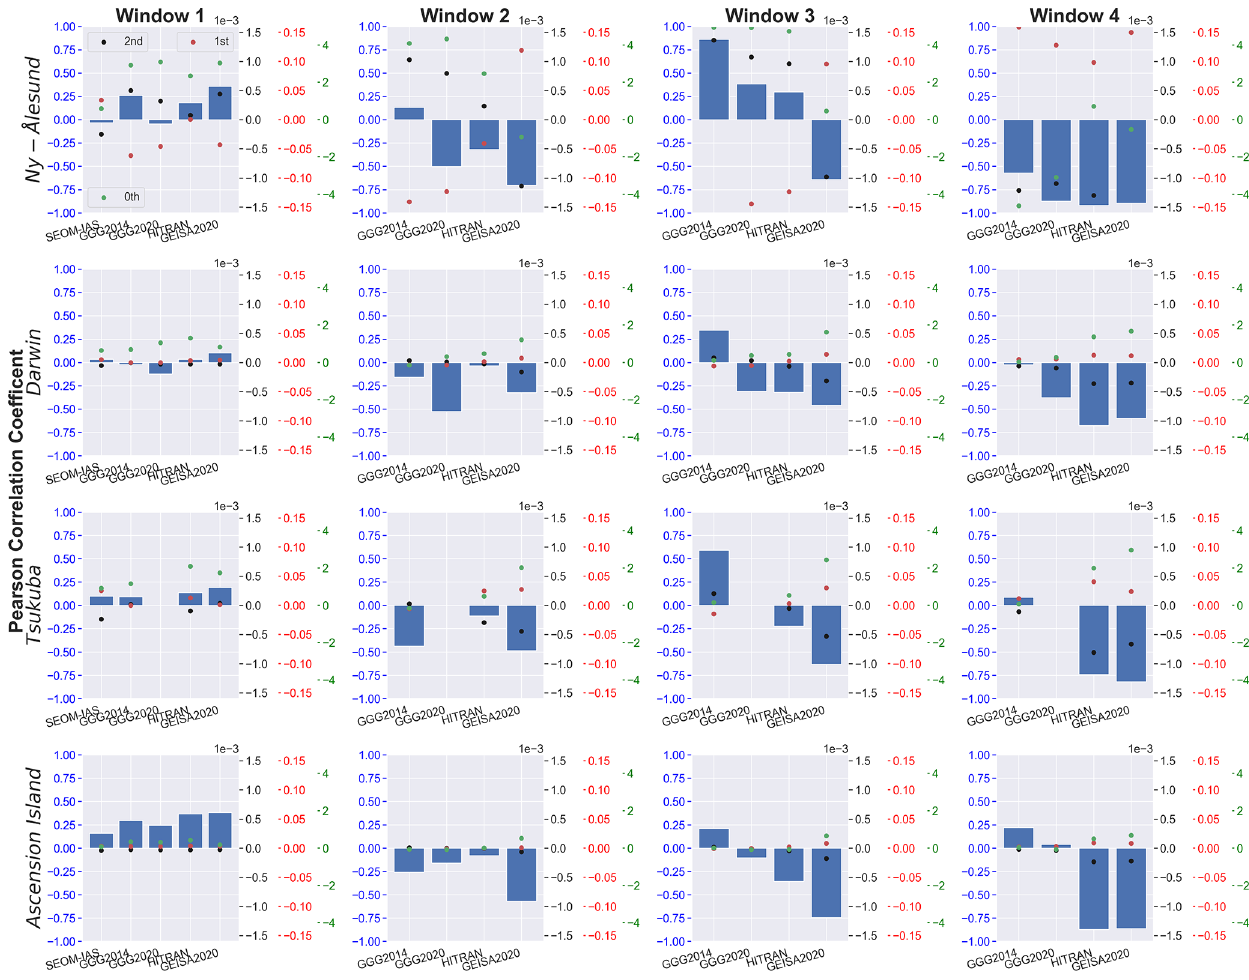
Figure 10. Bar and scatter charts indicating the statistics behind the sensitivities to SZA variations shown in Fig. 9. Each row indicates the results from a TCCON site, as indicated by the y -axis label; each column shows the results from a particular window as shown by the column title. The blue bar plots show Pearson’s correlation coefficients, with the left-hand blue y -axis values giving the appropriate scale. The black dots show the second-order coefficients from the regression from the fits shown in Fig. 9, with the right-hand black y -axis values as the scale. The red dots show the first-order coefficients, corresponding to the right-hand red y axis, and the green dots show the constant values corresponding to the right-hand green y axis. Note all values for GGG2020 at the Tsukuba site have been removed due to p -test